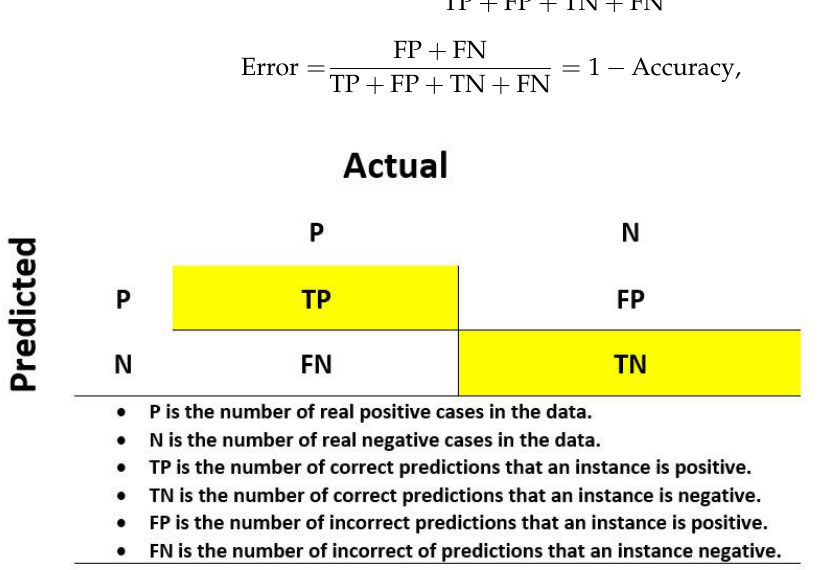
Figure 5. The basic scheme of the confusion matrix.